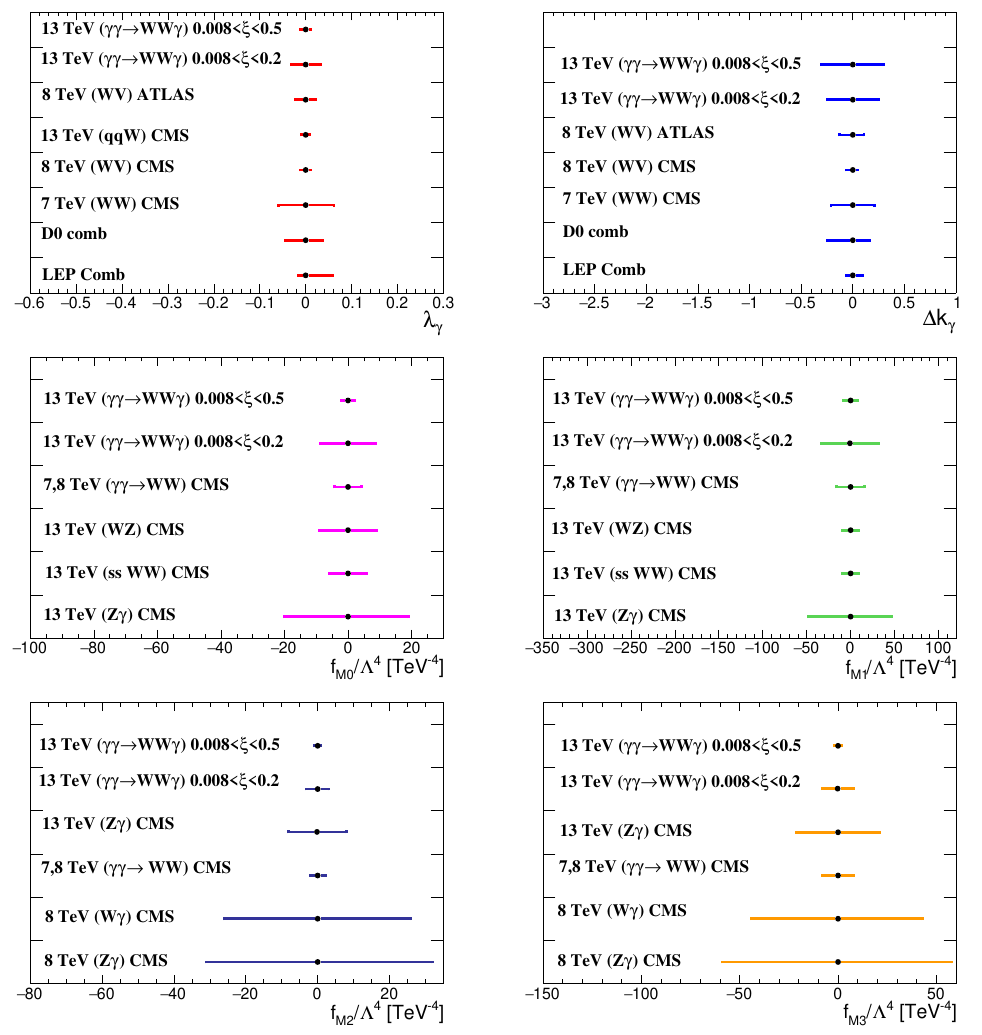
Figure 14 . Comparison of expected 95% C.L. limit on aTGCs and aQGCs obtained from (cid:13)(cid:13) ! WW(cid:13) analysis with center-of-mass energy of 13 TeV with current experimental observed limits [5, 6, 8{15,